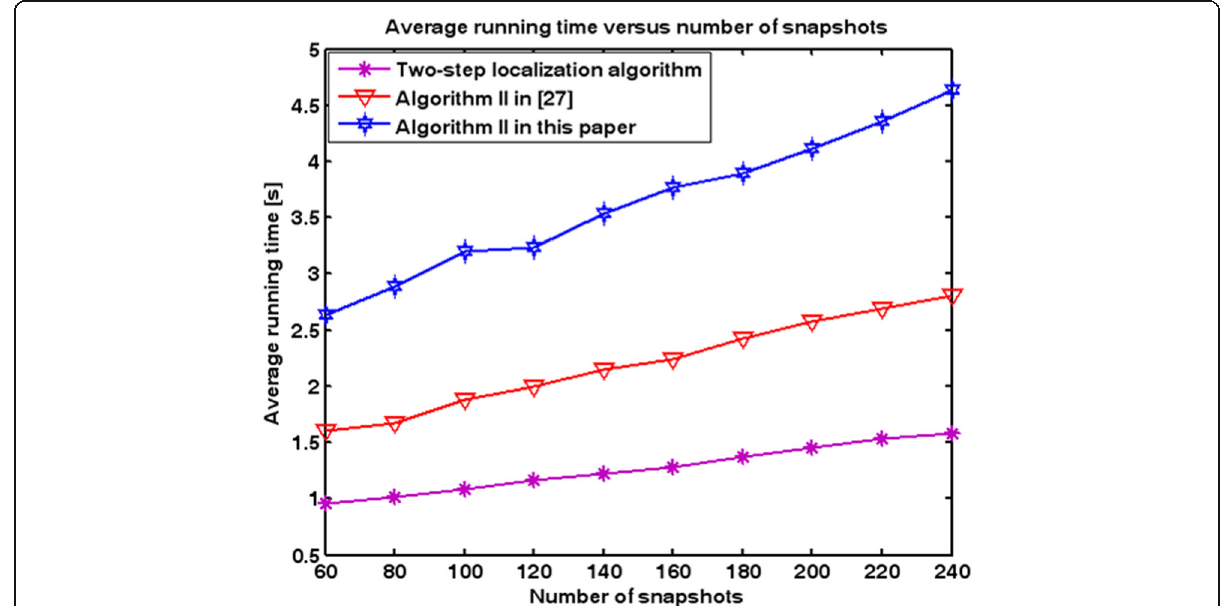
Fig. 14 Average running time as a function of the snapshot number (the second simulation results)